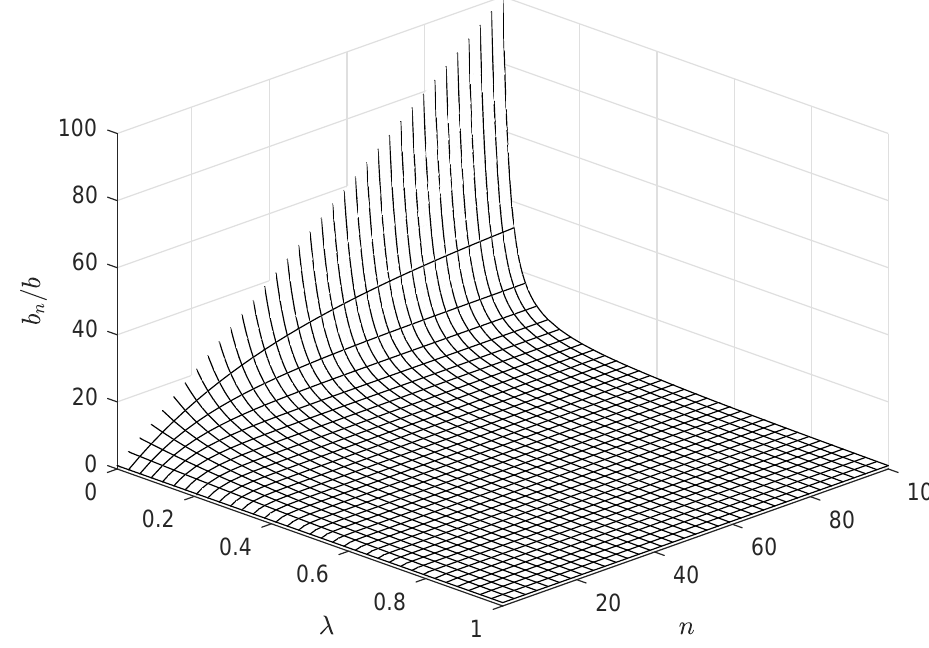
Figure 2. Representation of b n / b for varying λ and n